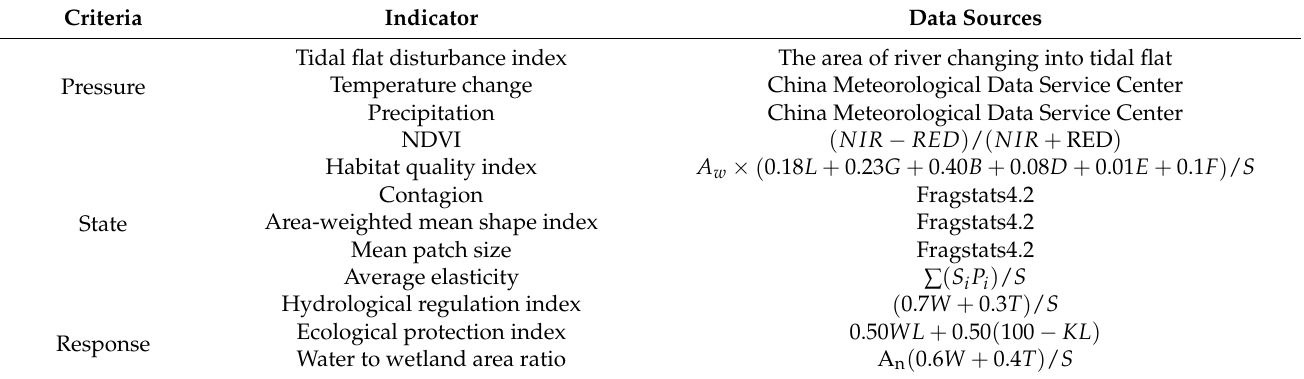
(Table 3). The health index system of S. salsa in the Liao River estuary wetland included three levels. The pressure indexes included a tidal flat disturbance index, temperature change and precipitation. The disturbance index of tidal flat was expressed by the area converted from river to beach every year. The average temperature and precipitation in spring and summer (March to August) were selected to express the temperature change and rainfall. The Normalised Vegetation Index (NDVI) and the habitat quality index of the S. salsa community indicate vegetation vitality. The three landscape indices are indicators that give a good indication of the structural organization of the landscape, and they were calculated by the Fragstats4.2 program. Fragstats 4.2 is a spatial pattern analysis program developed by McGarigal and Marks [33] for quantifying the structure of the landscape and is simple to use. The classification results are entered into the program, the metrics to be calculated are selected and the results are run. Average elasticity indicates the ability of wetland ecosystems to self-regulate and resist various stresses. The response indicators include the ecological protection index and wetland area ratio. In order to objectively evaluate the degradation of S. salsa wetlands in the Liao River estuary, data on the area of S. salsa are not used as indicators. Table 3. Parameters and sources of the PSR model evaluation